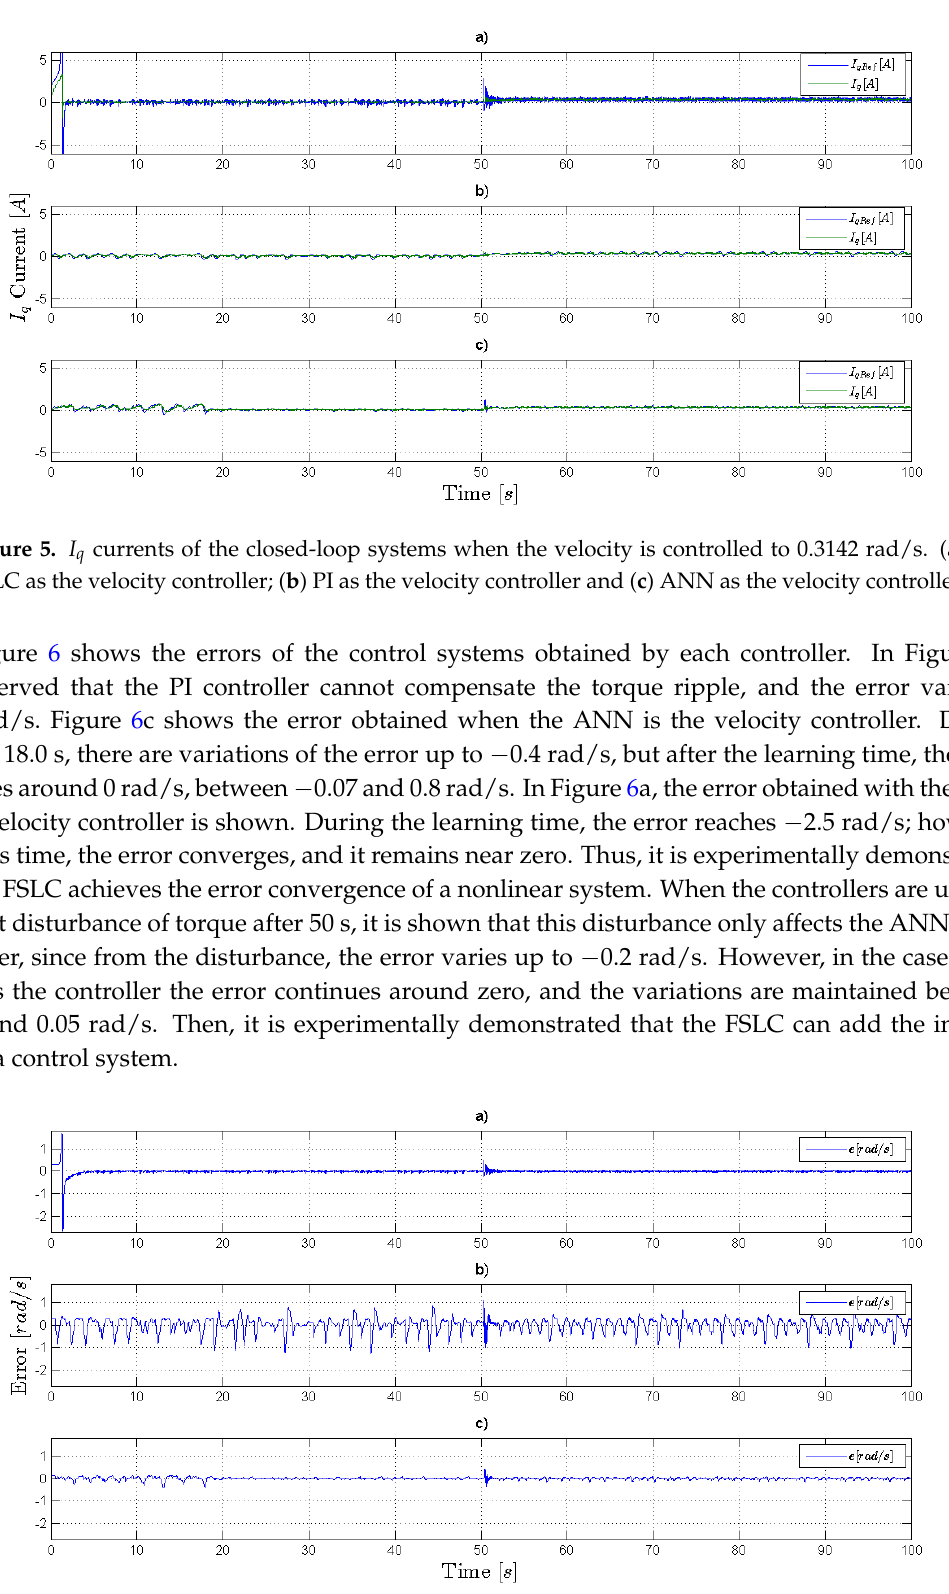
Figure 6. Errors of the control systems when the velocity is controlled to 0.3142 rad/s. ( a ) FSLC as the velocity controller; ( b ) PI as the velocity controller; and ( c ) ANN as the velocity